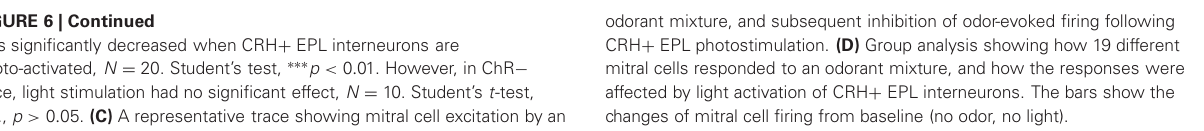
light-evoked postsynaptic currents in mitral cells. Bic, Bicuculline. APV + CNQX, n = 10; APV + CNQX + Bicuculline, n = 7. Student’s t -test, ∗∗ p < 0 . 025. Error bars represent SEM. (D) The recorded postsynaptic current was blocked by TTX. The shown data is the average of 10 repeated traces. (E) Unitary connectivity from a CRH + EPL interneuron to a mitral cell. A short pulse of current was injected into the CRH + EPL interneuron to evoke action potentials, and postsynaptic current was observed in the mitral cells (left). The postsynaptic currents were fully blocked by GABAzine (right). Jitters indicated by arrowheads are from external noises during the